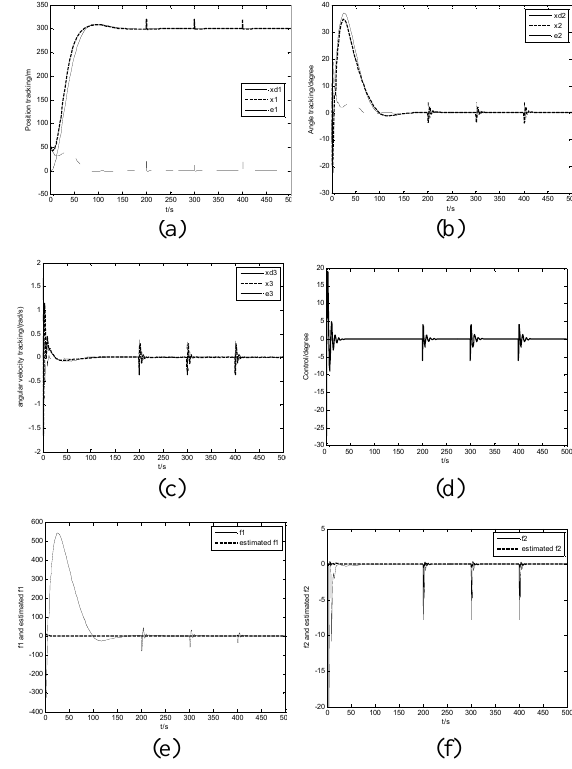
Fig. 6. Simulation results of the DES trajectories tracking in case III. (a) s way displacement (b) yaw angle (c) yaw rate f and estimated f (f) f and (d) control rudder angle (e) 1 1 2 estimated 2